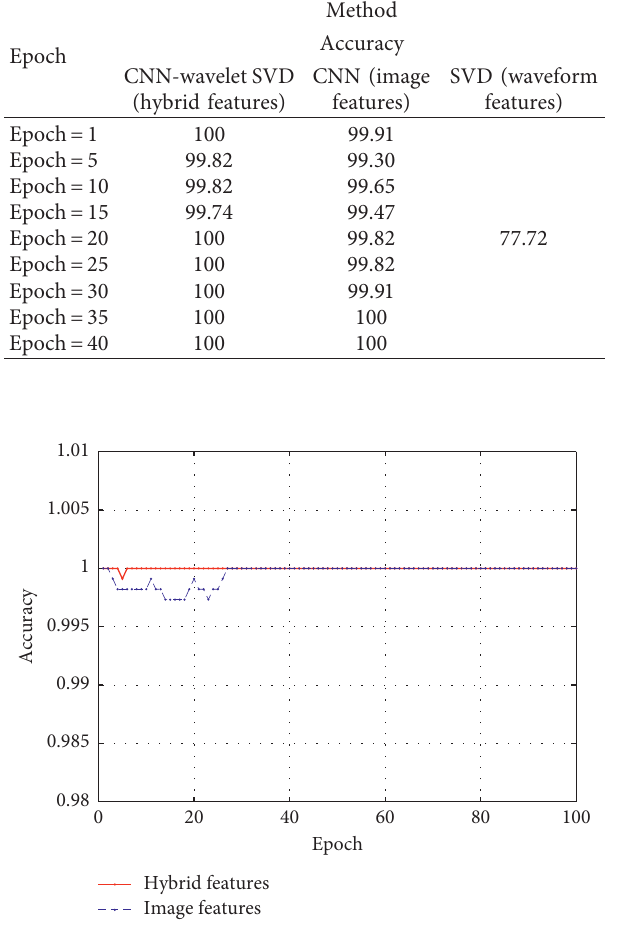
Figure 15: Recognition rate of SVM on different